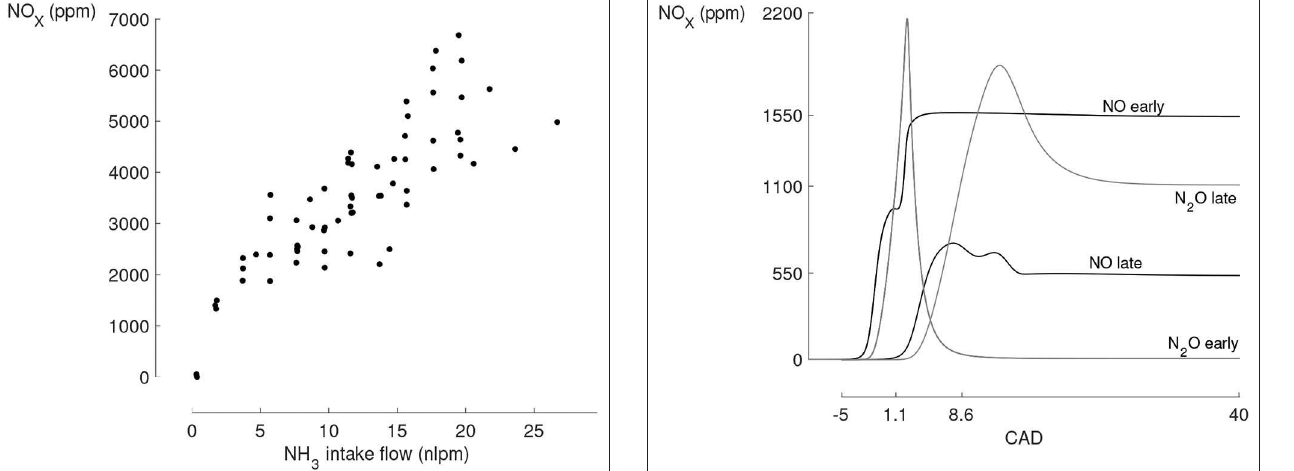
Although EGAR can have a drastic impact on NO X emissions, if no combustion temperature enhancing technique or quenching thickness reduction techniques is used (such as turbocharging or wall coating) the overall effect can be